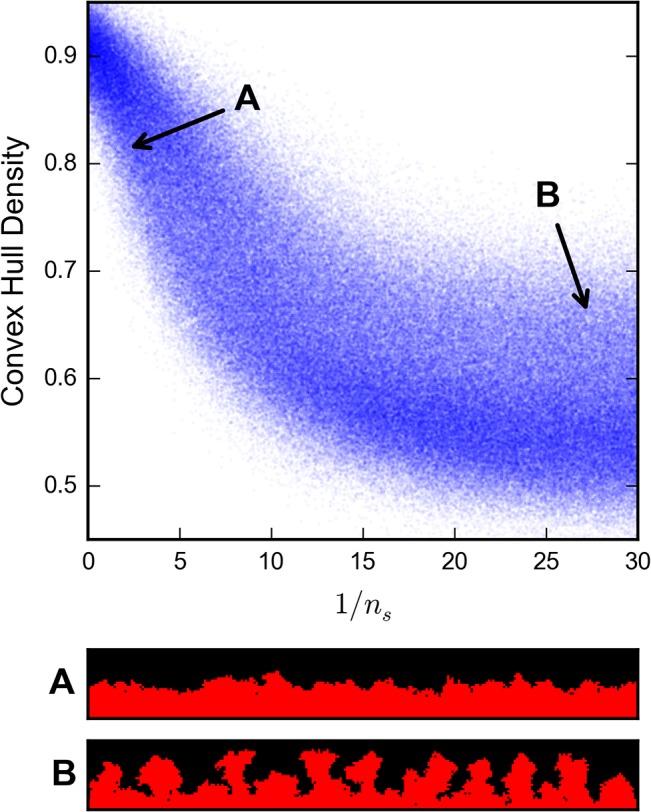
Increasing nutrient scarcity results in increased model biofilm porosity and propensity towards columnar structures.Panel A shows a dense, flat model output produced with b = 7 and low nutrient demand r = 0.04, while Panel B shows column and mushroom-like growths produced with b = 7 and high nutrient demand r = 0.56. Nutrient scarcity in the model is characterized by the dimensionless quantity 1 / n
s = b
2
r which is large for nutrient-deprived regimes. We use convex hull density (the density of biofilm-filled cells contained in the convex hull area of the biofilm) as a metric for biofilm porosity. 300,000 samples were taken over the parameter subset (b, r) such that 1 ≤ b ≤ 16, 10−3 ≤ r ≤ 30, 1 / b
2
r ≤ 30, with fixed values α = 2, β = 1, and n
1/2 = 0.25. Each of the model samples was grown to the same total mass of 2 × 103 cells.